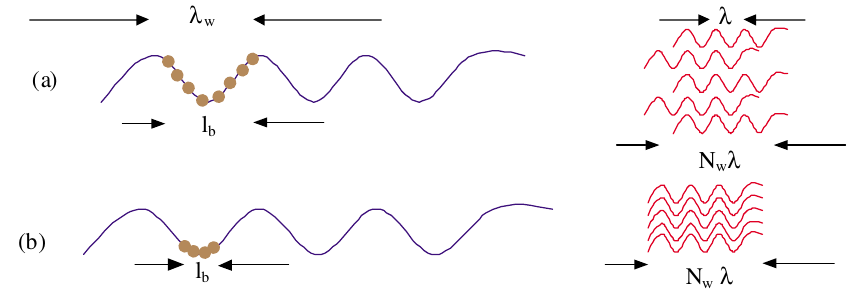
FIG. 2. (Color) Synchrotron-undulator emission from an electron beam bunch: (a) incoherent emission of uncorrelated radiation wave > (cid:9) and (b) coherent emission of phase correlated wave packets (superradiant emission) packets (FEL spontaneous emission) l b (cid:6) (cid:9) l b